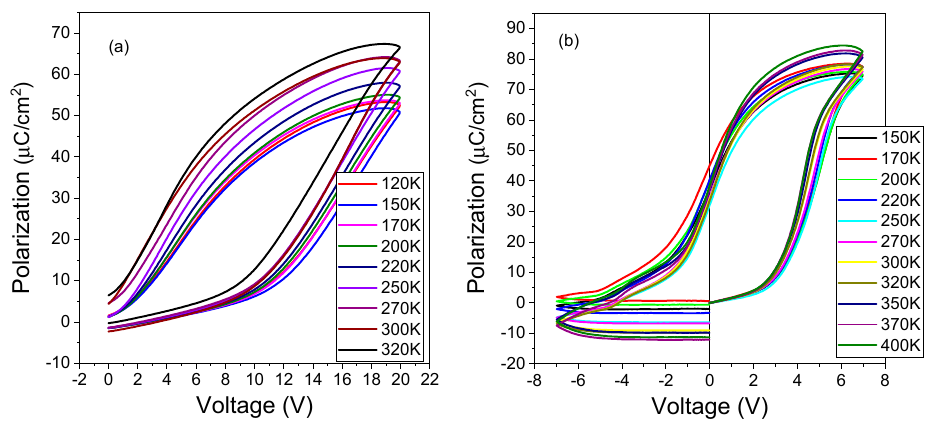
Figure 5. ( a , b ) The hysteresis measurements performed at different temperatures for Nb 2 O 5 /PZT/SRO and BST/PZT/SRO/STO.